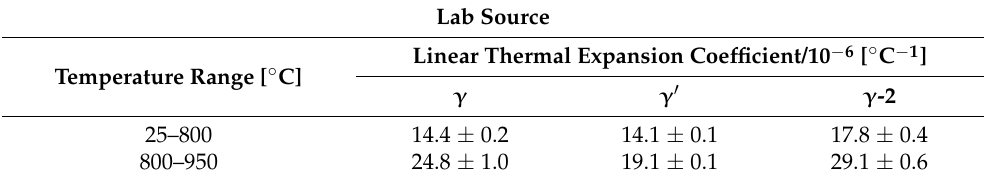
Table 3. Linear thermal expansion coefficient of the different phases determined by lab-source XRD in the two temperature